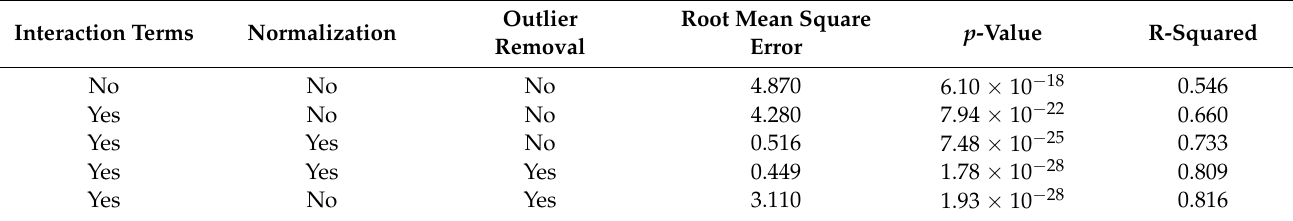
Table 7. Results for the multiple linear regression using obesity as a